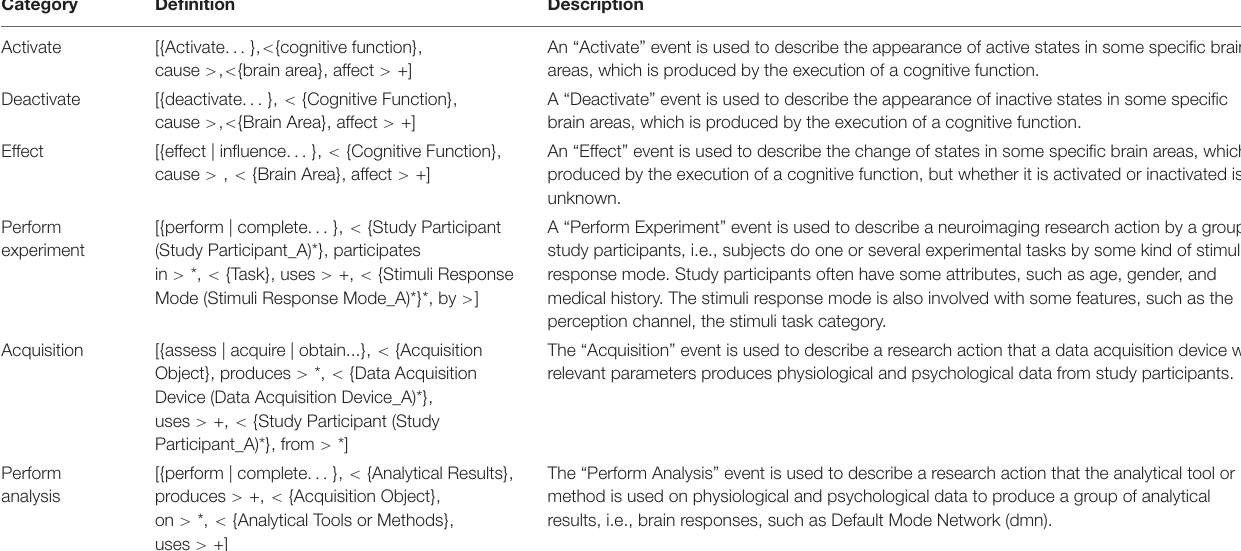
TABLE 1 | Neuroimaging event category.